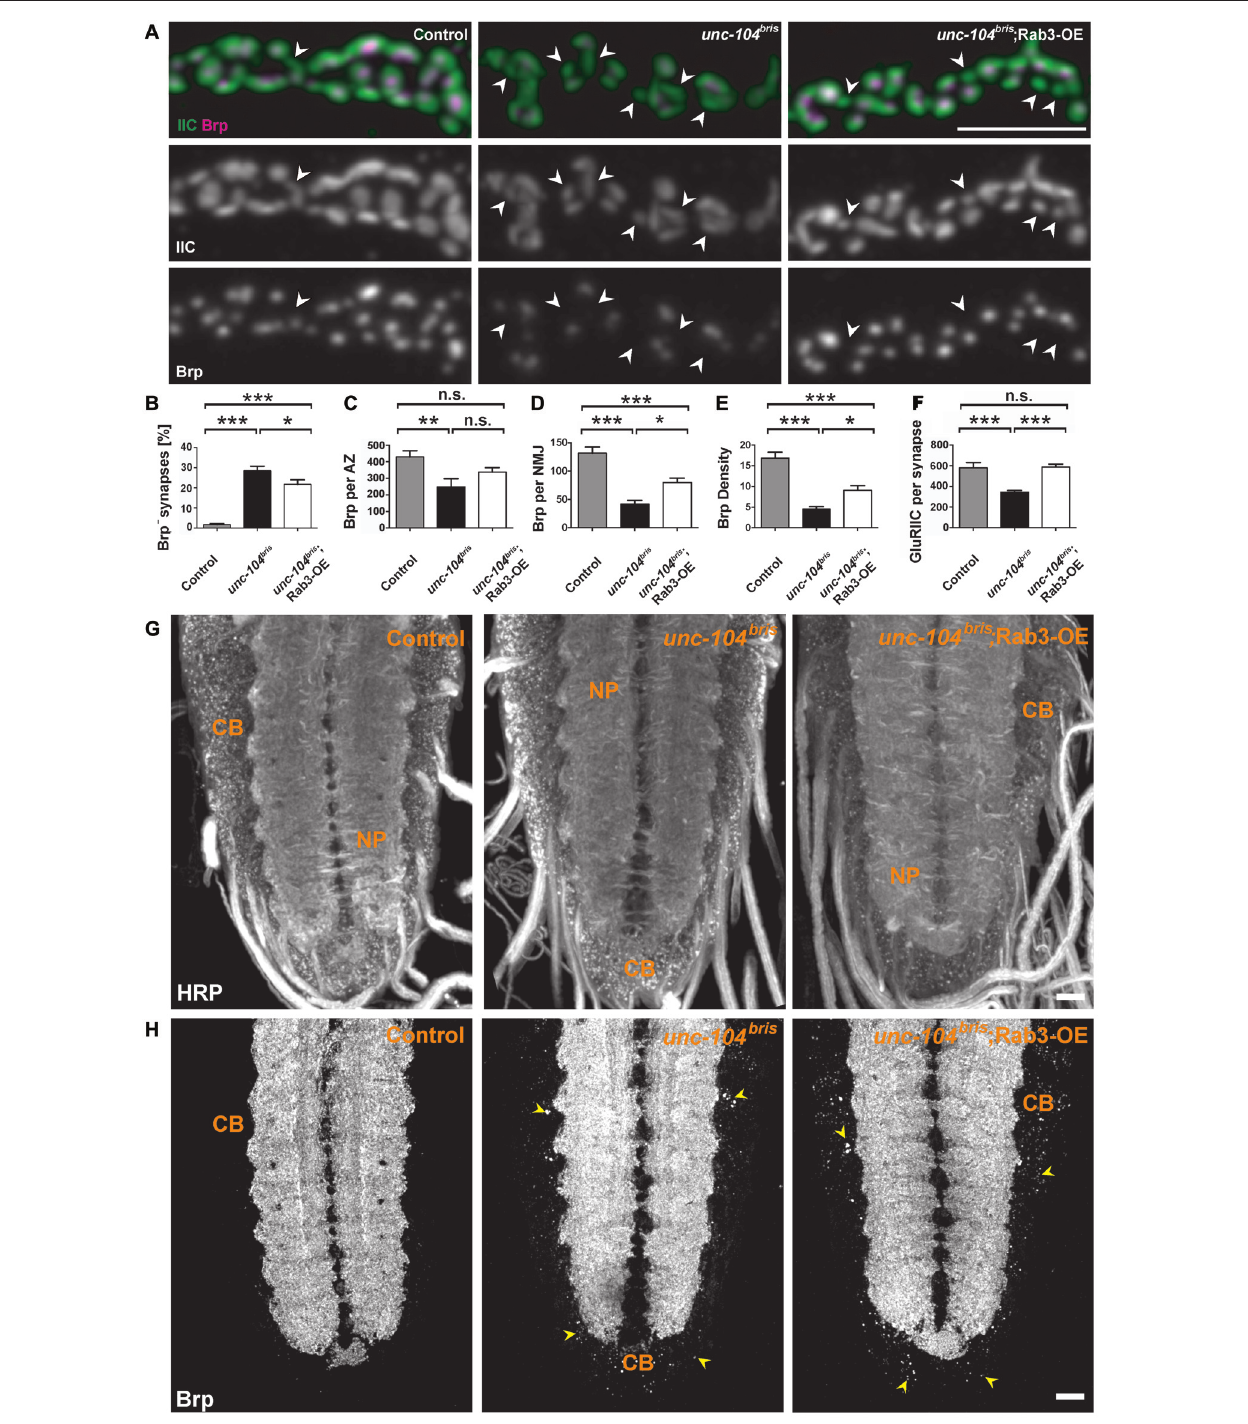
FIGURE 6 | Rab3 ectopic expression partially ameliorates unc-104 bris mutant phenotypes at the NMJ but not VNC phenotype. (A) A stretch of synaptic boutons at the NMJ costained with antibodies against GluRIIC (green in upper panel, gray in 2nd panel) and Brp (magenta in upper panel, gray in 3rd panel). (B–F) Quantifications of percentage Brp − synapses (B) and Brp content per Brp + AZ (in a.u.; C ) reveal that the percentage of Brp − synapses decreases upon Rab3 expression and the size of each Brp puncta remains unchanged. Brp content per NMJ (in a.u.; D ) as well as the Brp density (in a.u.; Brp content normalized by HRP area) (E) increase following Rab3 expression. Expression of Rab3 fully rescues GluRIIC levels (in a.u.) at postsynaptic density (PSD) of unc-104 bris mutant NMJs to control levels (F) . (G,H) Representative confocal images from larval VNC stained with antibodies against HRP (G) and Brp (H) . (H) Abnormal accumulation